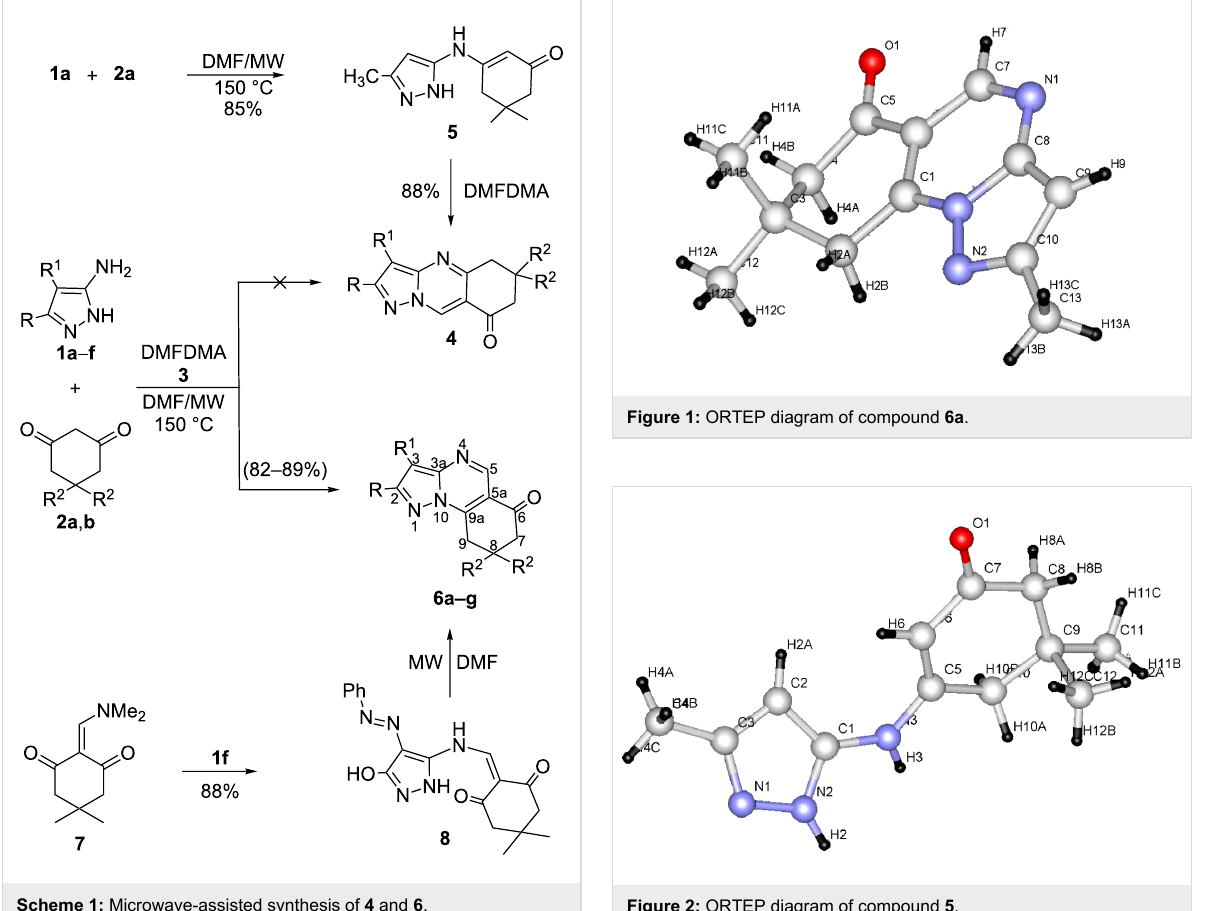
Figure 2: ORTEP diagram of compound 5 .